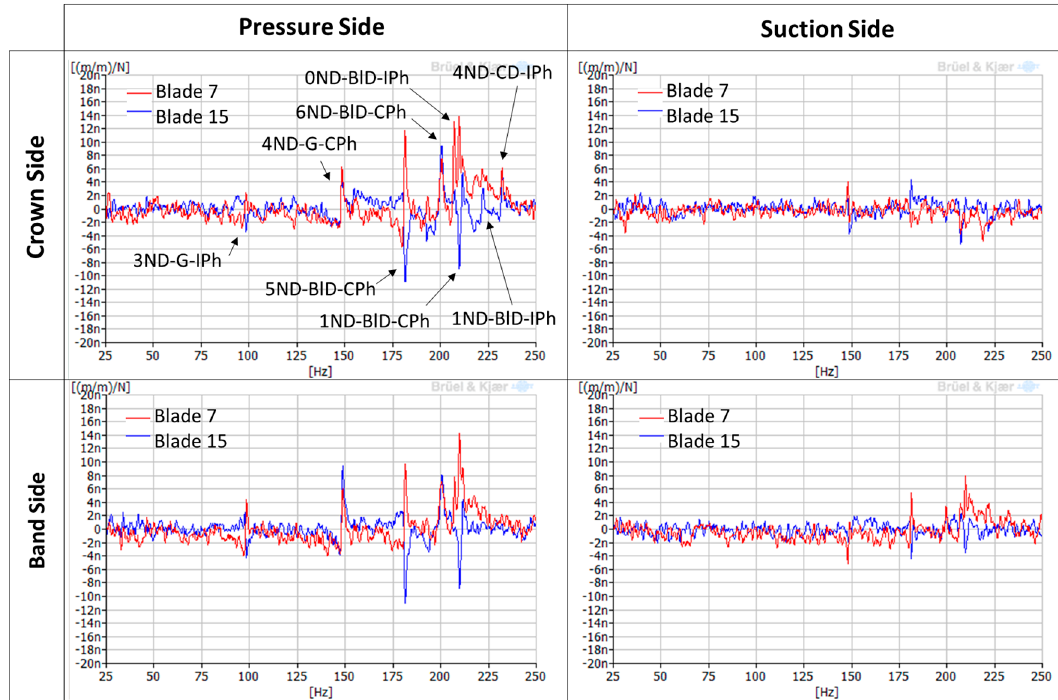
Figure 8. FRFs (only the real part) of different strain gauges with the hammer as a reference (impact in blade 7).